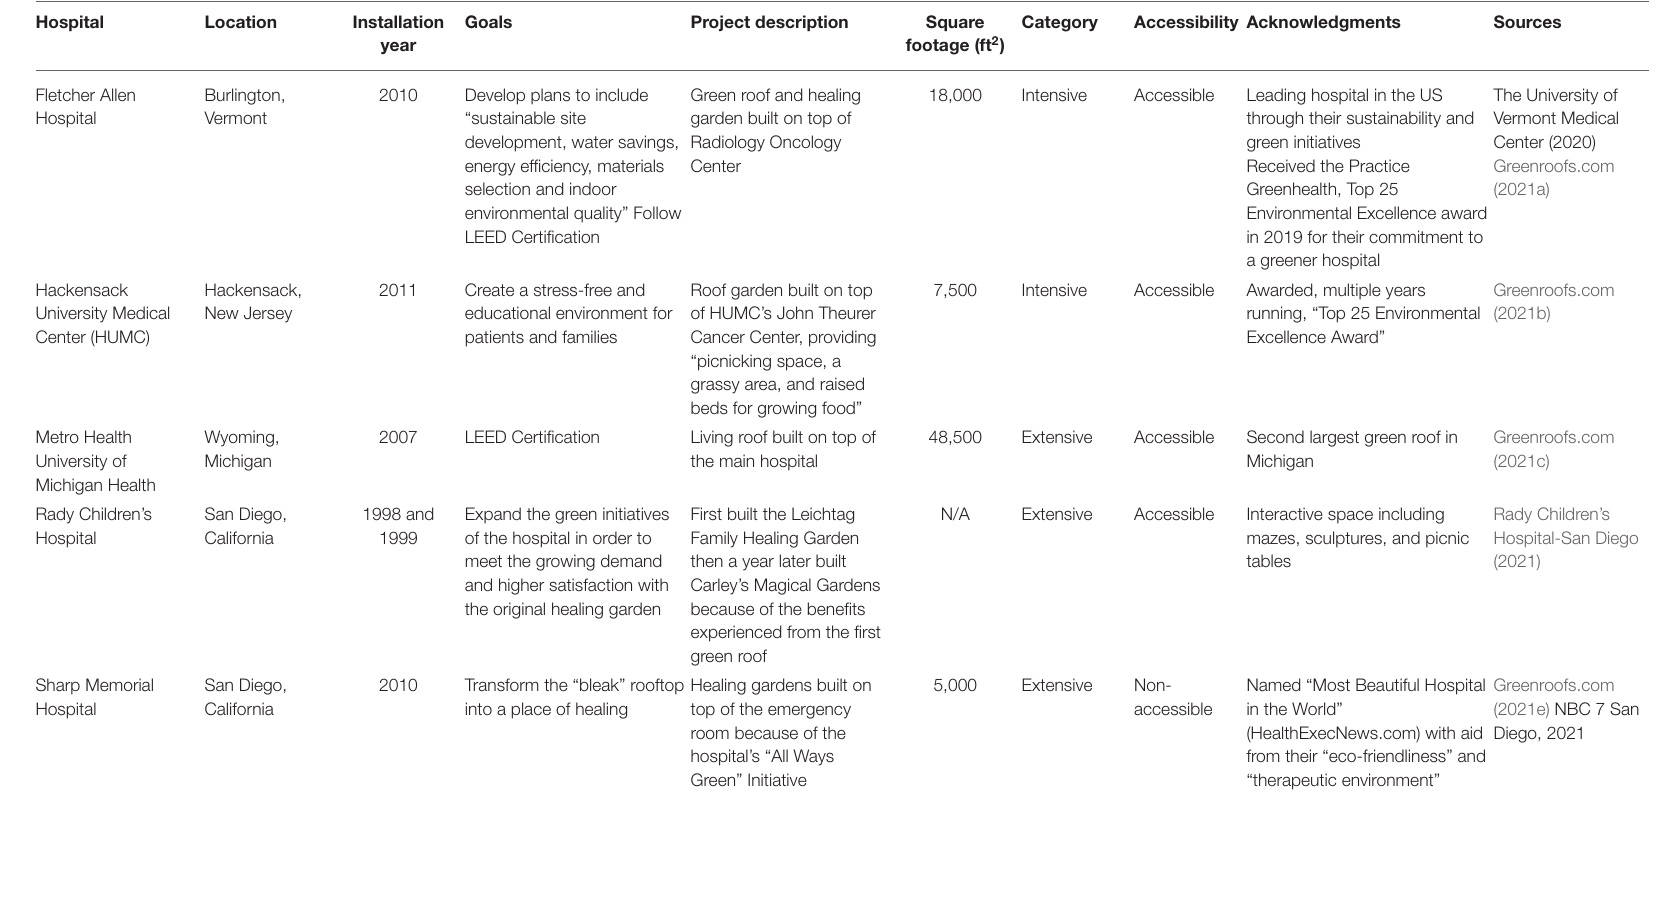
TABLE 1 | Hospital green roof